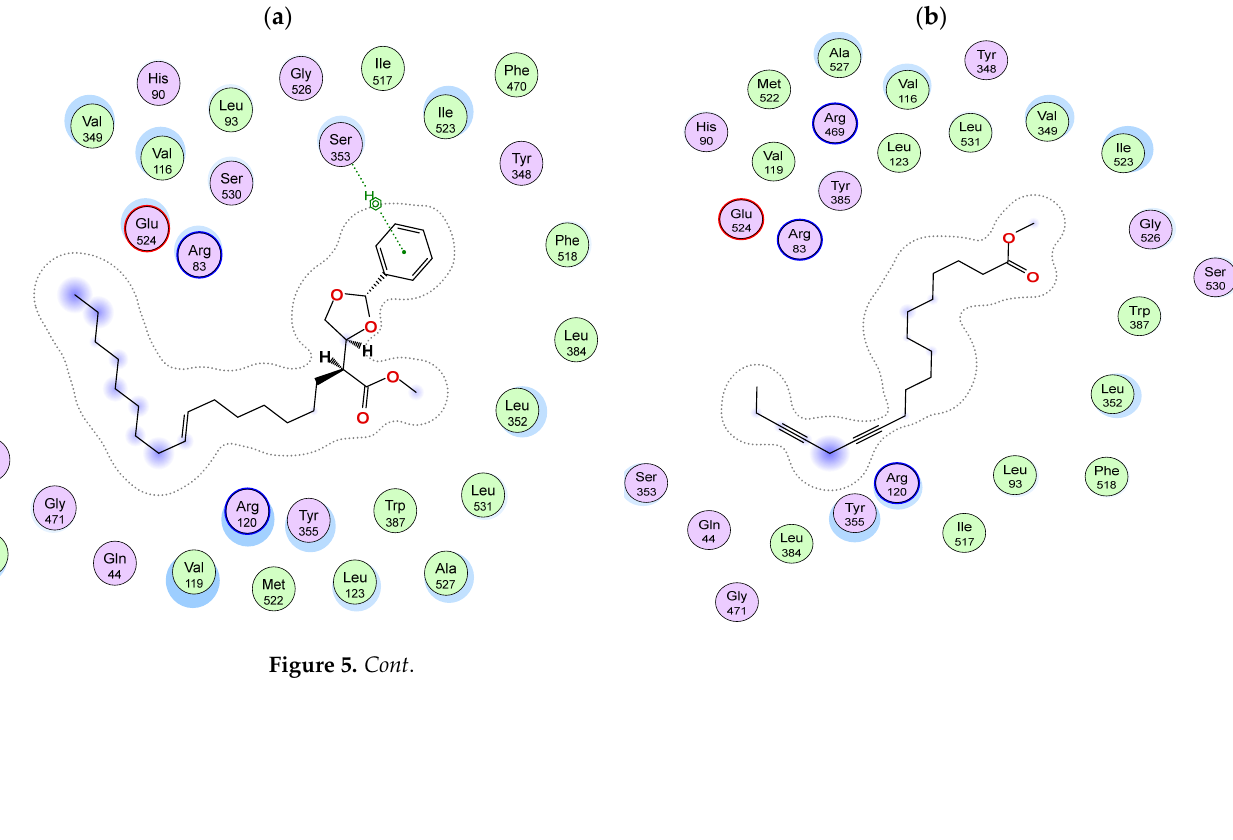
Figure 4. Binding poses of ( a ) metabolite 66 “green” and ( b ) metabolites 17 “green” and 46 “yellow” into the COX-1 active site; ligands are depicted with a stick model. The residues are shown in labelled wire models.